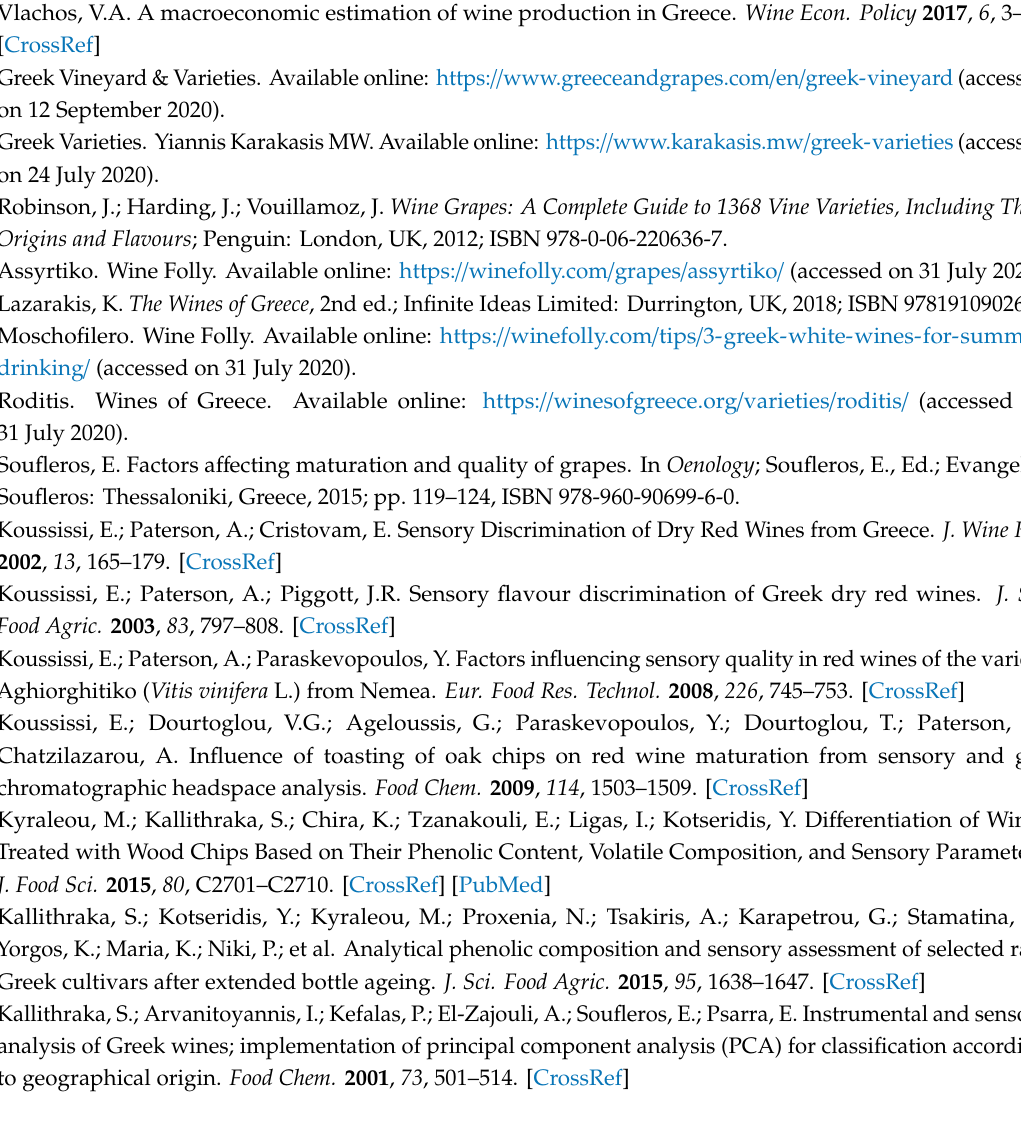
Table S1: Chi-Square, R , and p 11 values for each of the panelists